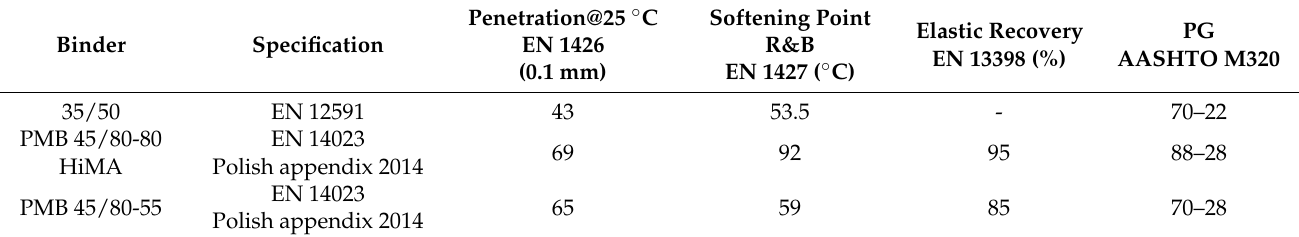
Table 1. Basic properties of the binders used in the asphalt mixtures.